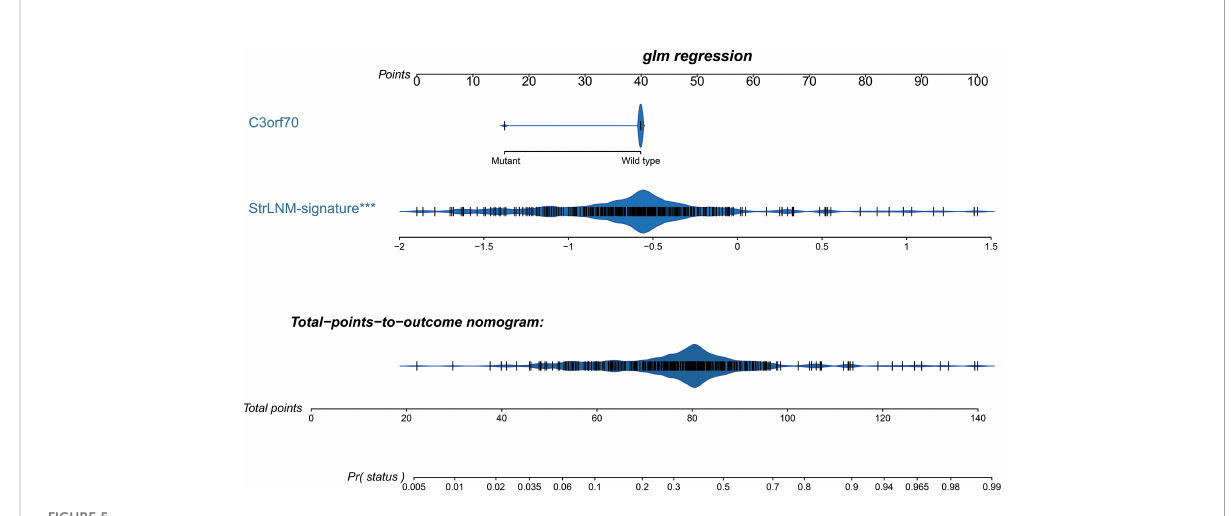
FIGURE 5 Development of preoperative StrLNM nomogram. By incorporating the StrLNM signature and genomic mutation of C3orf70, the StrLNM nomogram was built in the training dataset of the TCGA-BLCA